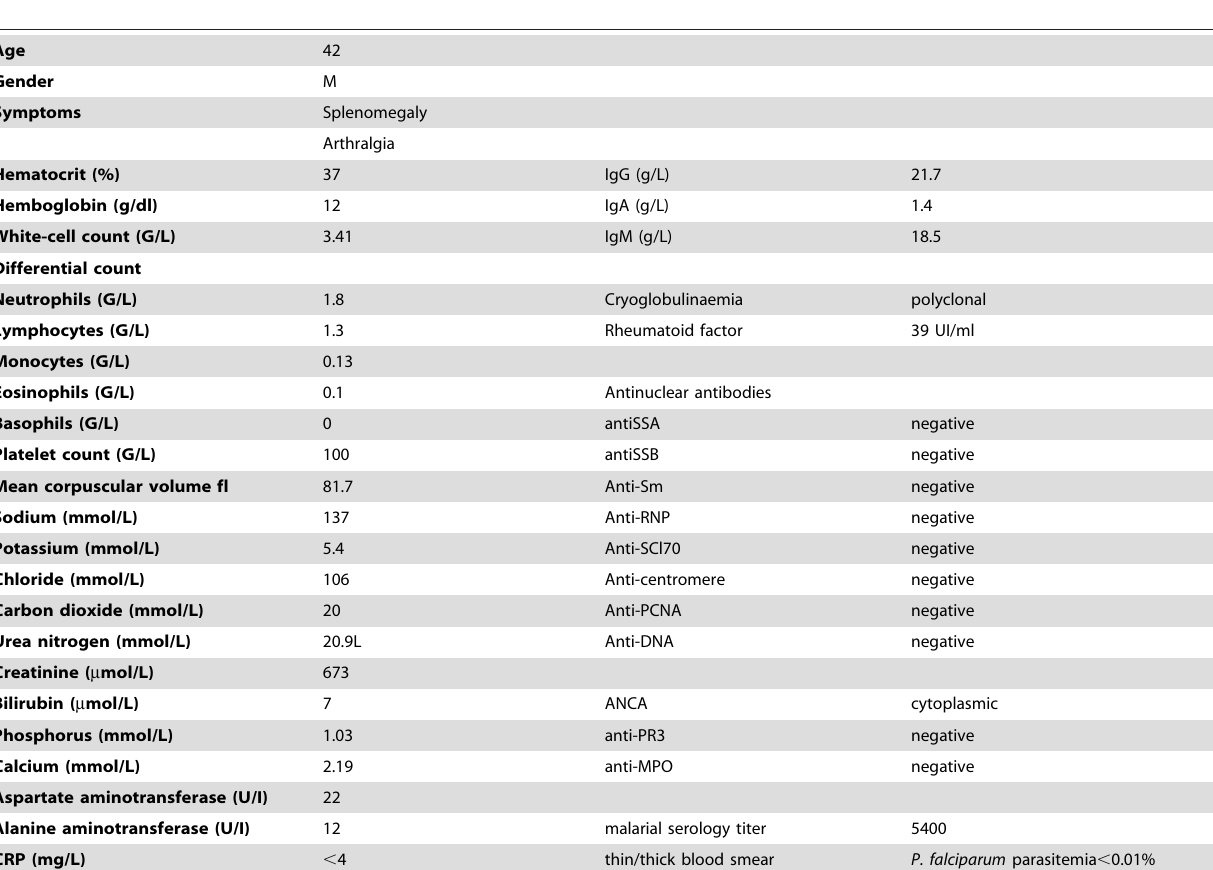
Table 1. Index case: Clinical and biological